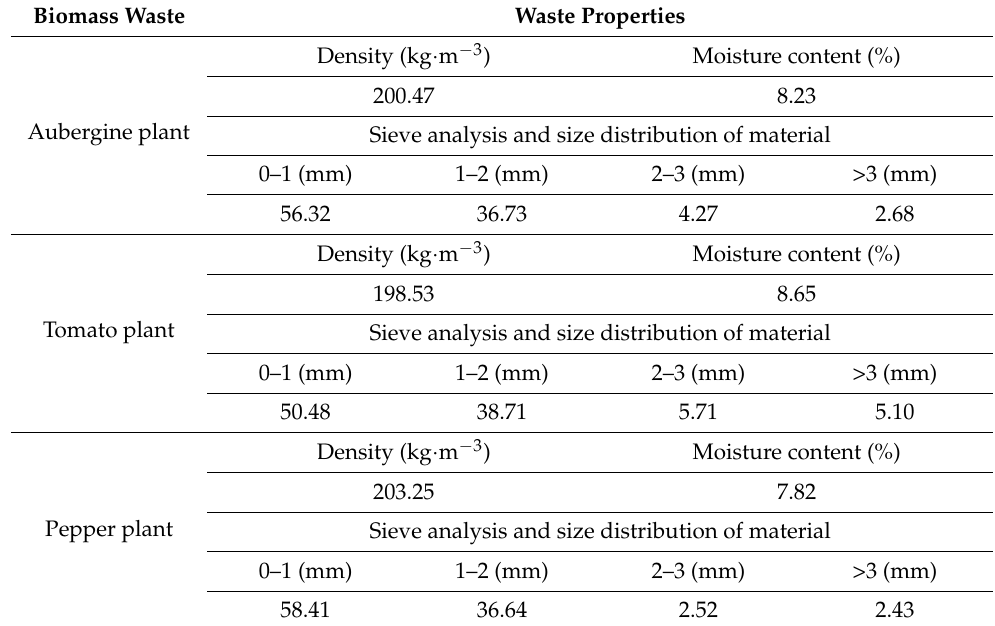
Table 1. Properties of ground pepper, tomato and eggplant waste used in the experiments. Biomass